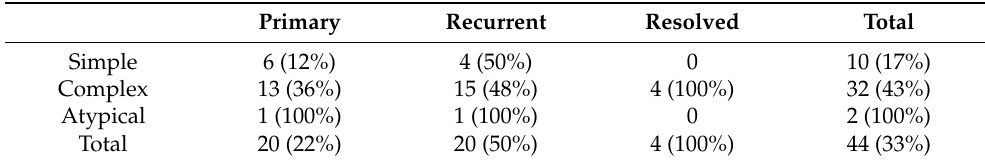
Table 3. Incidence of CNV among CSCR sub-types (% of total